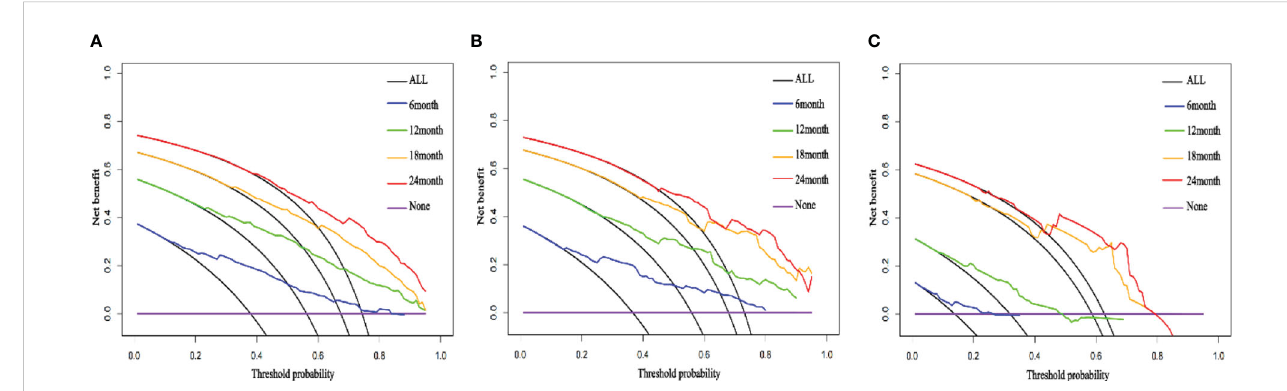
FIGURE 6 The DCA curves of the nomogram; the DCA curve of 6-, 12-,18- and 24- months OS for the training cohort (A) , internal validation cohort (B) , external validation cohort (C) .